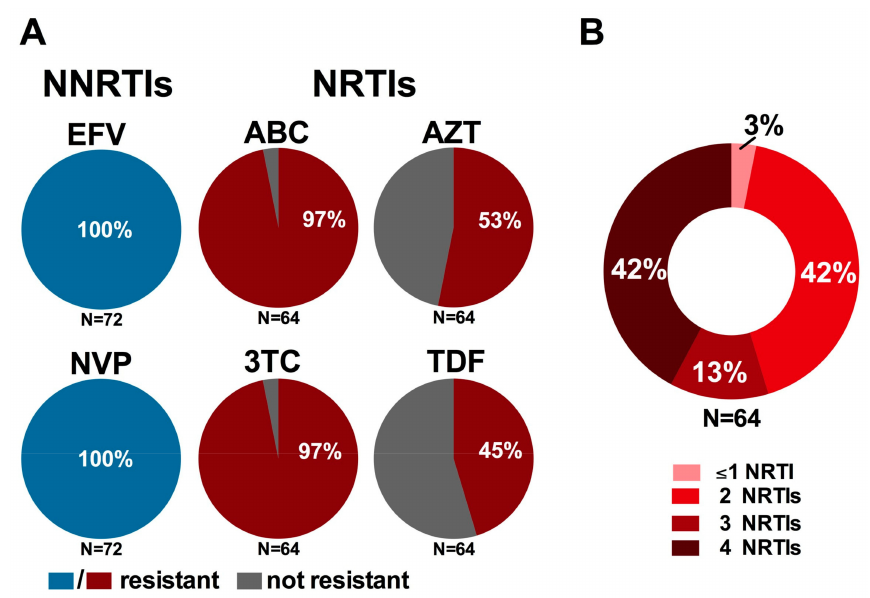
Figure 3. Implications of resistant genotypes on recommended first- and second-line regimens: ( A ) prevalence of resistance to recommended first-line NNRTIs (blue) and NRTIs (red) among participants harboring NNRTI ( N = 72) and NRTI ( N = 64) resistance, respectively; and ( B ) burden of multi-NRTI resistance among participants harboring NRTI resistance ( N = 64). Resistance to individual drugs was defined using the Stanford Drug Resistance Database, where genotypes exhibiting any